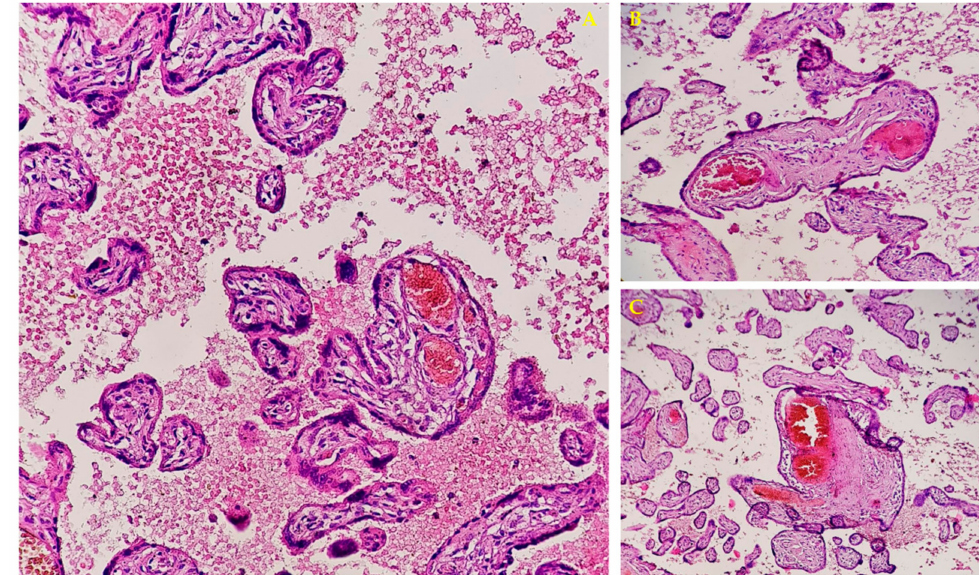
Figure 4. ( A ) 100 × and ( B , C ) 400 × HE stain of placenta (second half of gestation period), with vascular stasis and recent thrombi, lacking signs of endothelial activation, minimal inflammatory infiltrate, perivillous fibrin, and increased syncytial